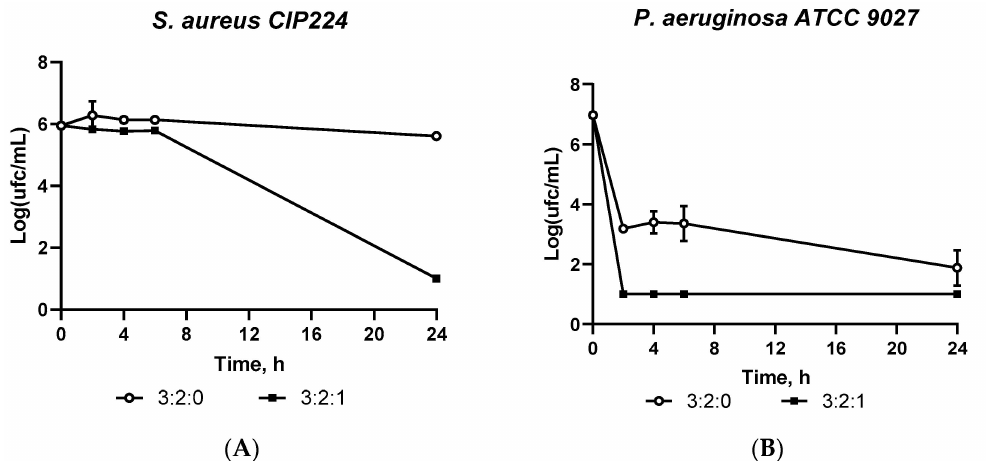
Figure 7. Antibiofilm evaluation in a hydroxyapatite-coated peg over time for ( A ) S. aureus and ( B ) P. aeruginosa